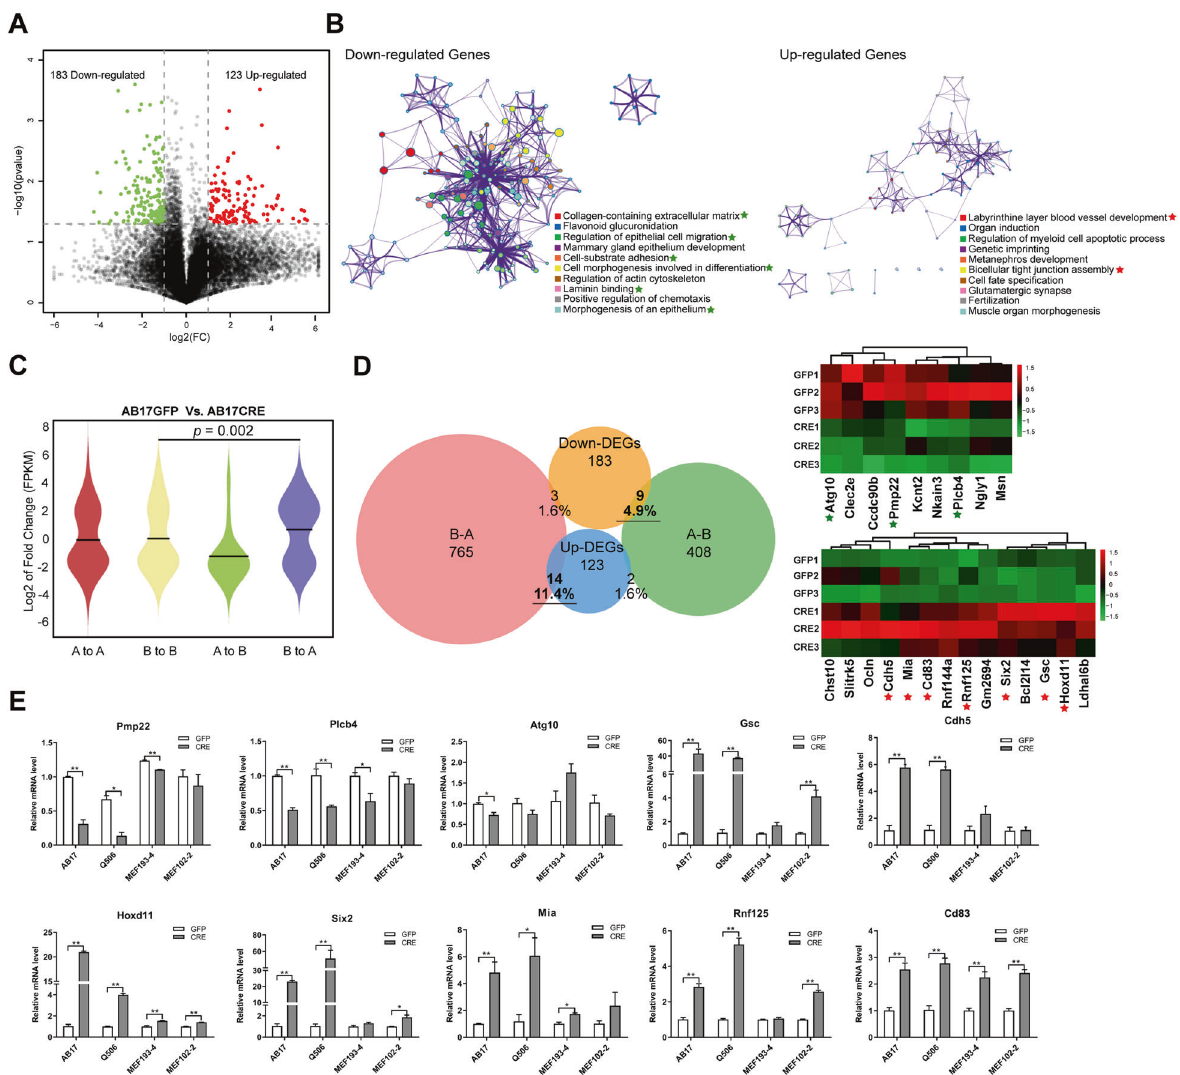
Fig. 4 Compartment switching dysregulates cancer-related genes. A Volcano plot showing the DEGs (fold change >2, p value <0.05) between Arid1a WT (Ad-GFP) and KO (Ad-Cre) AB17 cells. The green and red dots represent down- and up-regulated genes post Arid1a de fi ciency, respectively. B The enrichment analysis on down- (Left) and up-regulated (Right) genes. The top ten signi fi cantly enriched terms were shown ( p value <0.01). The color-coded circles symbolize the enriched GO terms and pathways. C Fold change (Ad-Cre/Ad-GFP log2) of mRNA expression (FPKM) of the genes residing at regions with compartment switching. D Venn diagrams displaying the overlap of DEGs and A/B compartment switch-related genes (Left). The heatmap showing the expression pro fi les of the switching compartments controlled-genes with triplicate datasets, of which down- and up-regulated cancer-related genes labelled by green and red pentagrams, respectively (Right). E qRT-PCR for the compartment switching-controlled genes in Arid1a WT (Ad-GFP) and KO (Ad-Cre) AB17 and Q506 hepatocytes as well as MEFs (193-4 and 102-2 cells) with three biological replicates. Error bars were painted by SEM. p value was calculated by a two-tailed Student ’ s t -test. mRNA expression of Gapdh was employed as an internal